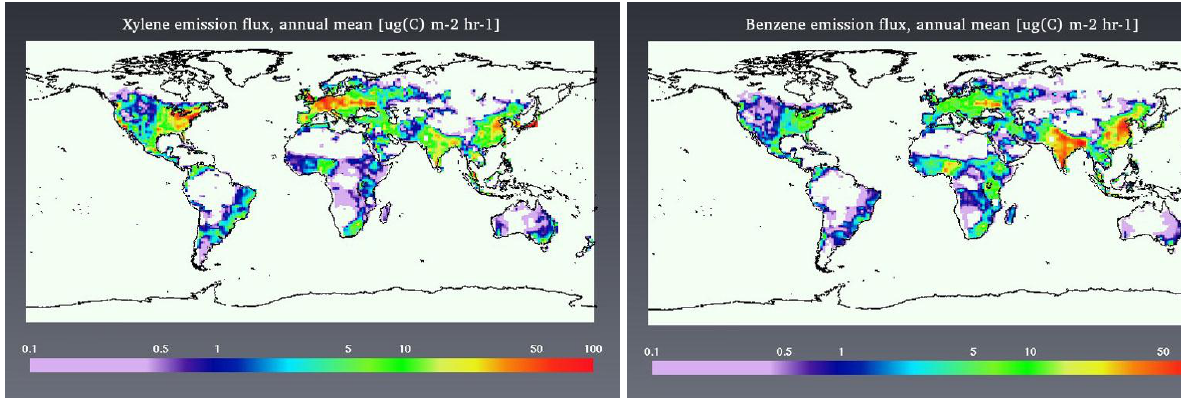
Figure 1. Anthropogenic SOA precursor emissions.